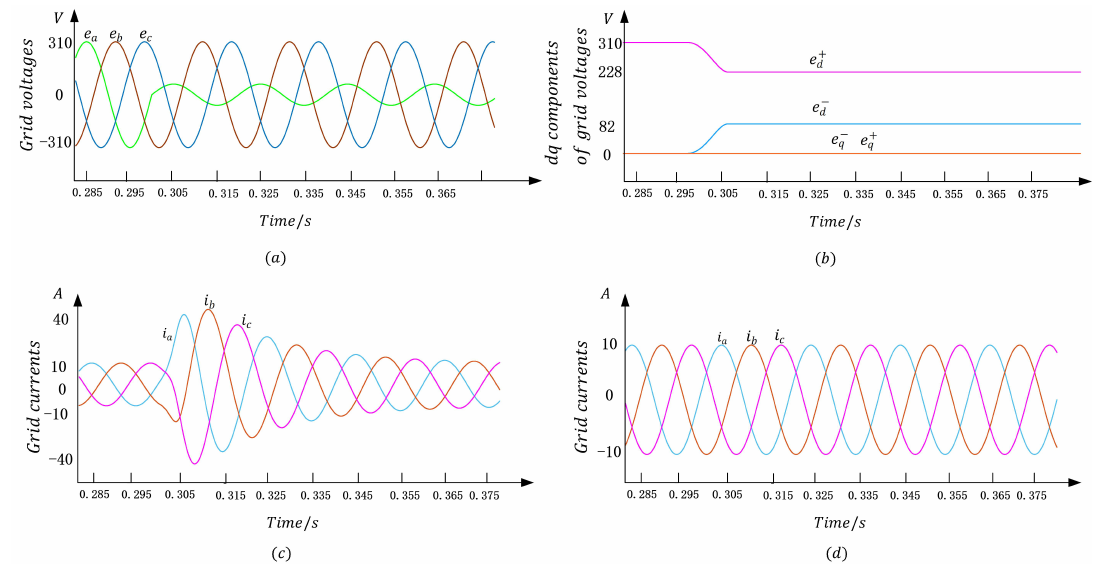
Figure 7. Grid voltages ( a ). Positive and negative sequence dq component of grid voltages ( b ). Grid currents of PI closed-loop control ( c ). Grid currents of ADP closed-loop control ( d ). Table 1. Overshoot of grid